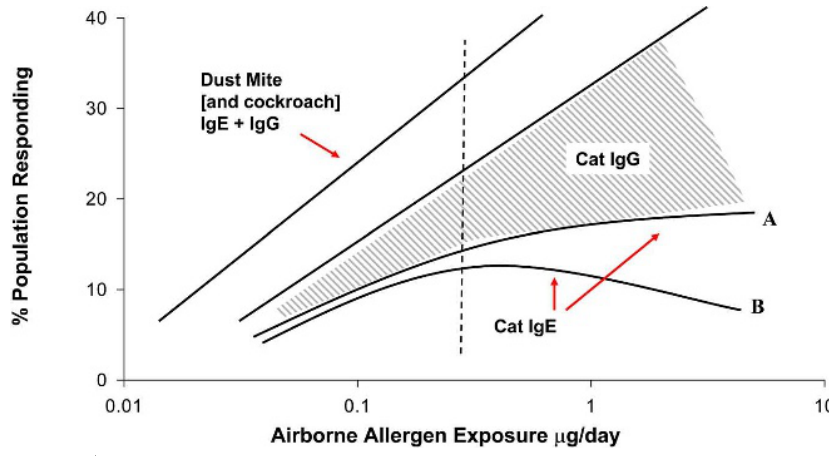
DOI: 10.1371/journal.pmed.0020034.g002 Figure 2. Contrast between Exposure to Dust Mite or Cat Allergens and the Relevant Immune Responses The dashed line indicates the approximate value of 20 mg Fel d 1/g fl oor dust or the presence of a